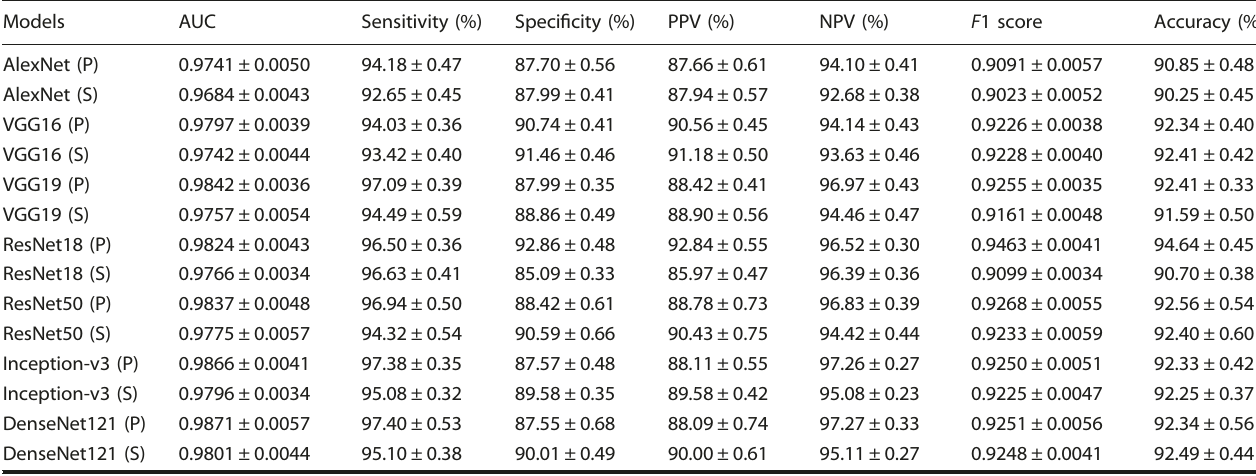
Table 1. Classi fi cation performance metrics for different CNN architectures on the NIH “ ChestX-ray 14 ” database.